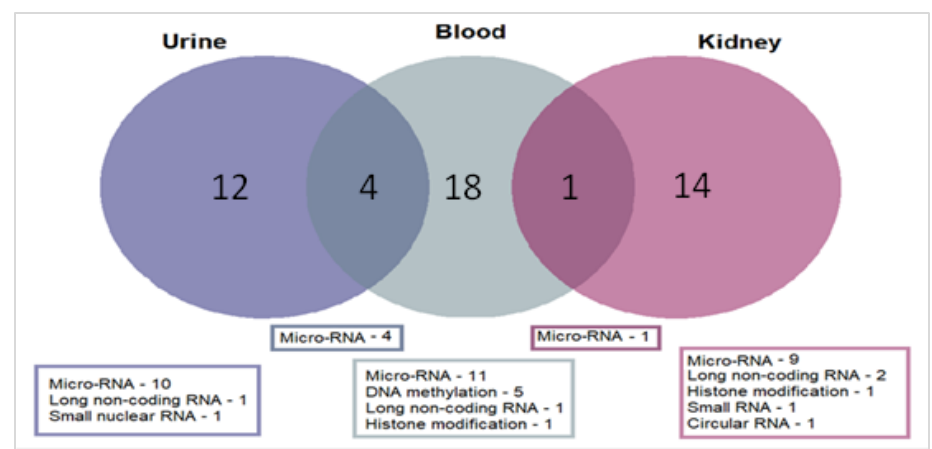
Figure 3 . Number of studies by epigenetic mechanism and tissue . Figure 3. Number of studies by epigenetic mechanism and